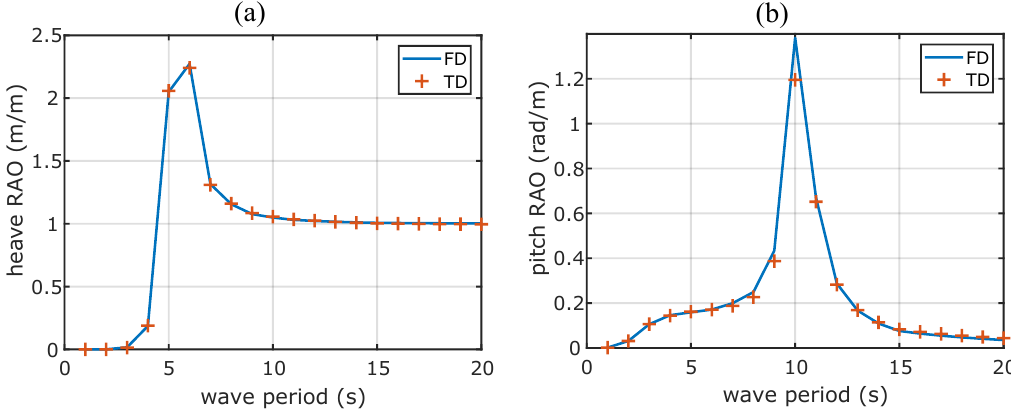
Fig. 5. Comparison between the time- and frequency-domains liner models in terms of response amplitude operator (RAO) in (a) heave, and (b) pitch modes, respectively.